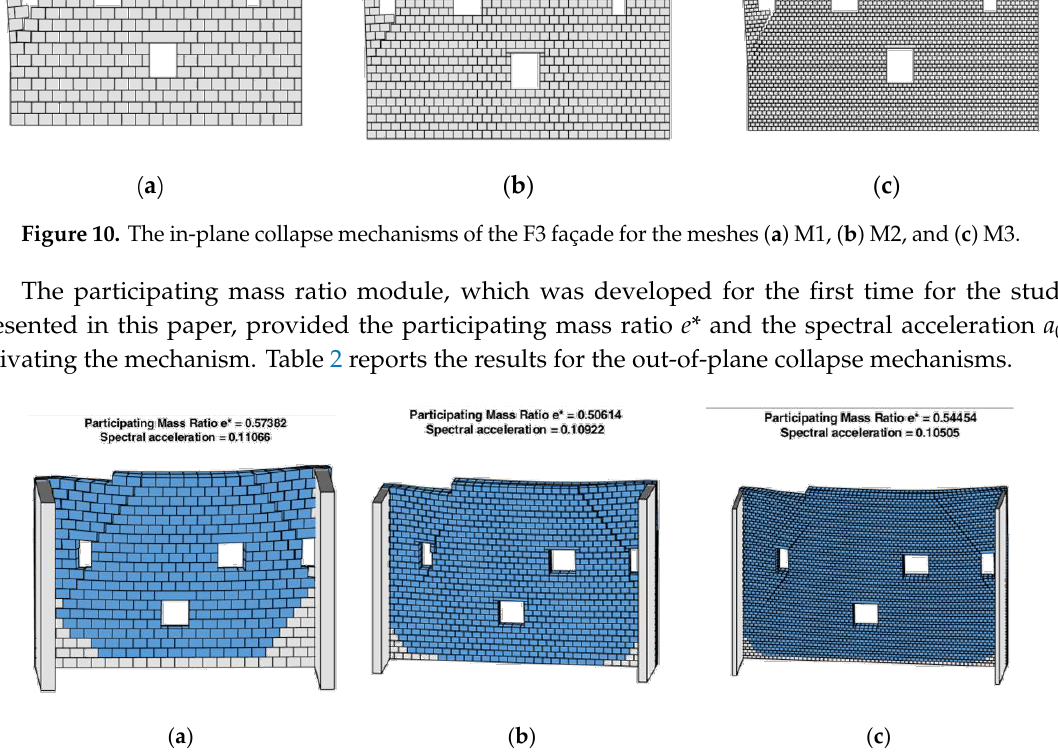
Figure 11. The out-of-plane collapse mechanisms of the F3 façade with participating mass in blue for the meshes ( a ) M1, ( b ) M2, and ( c ) M3. Table 2. Results for the out-of-plane collapse mechanisms of the F3 façade.